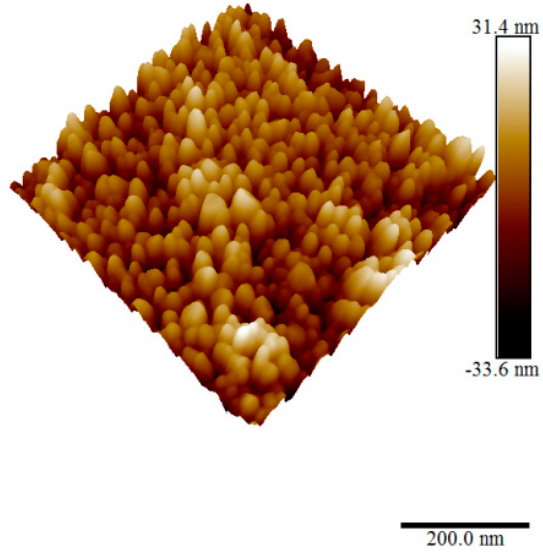
Figure 10. Three-dimensional AFM image of nanostructured ZnO film.